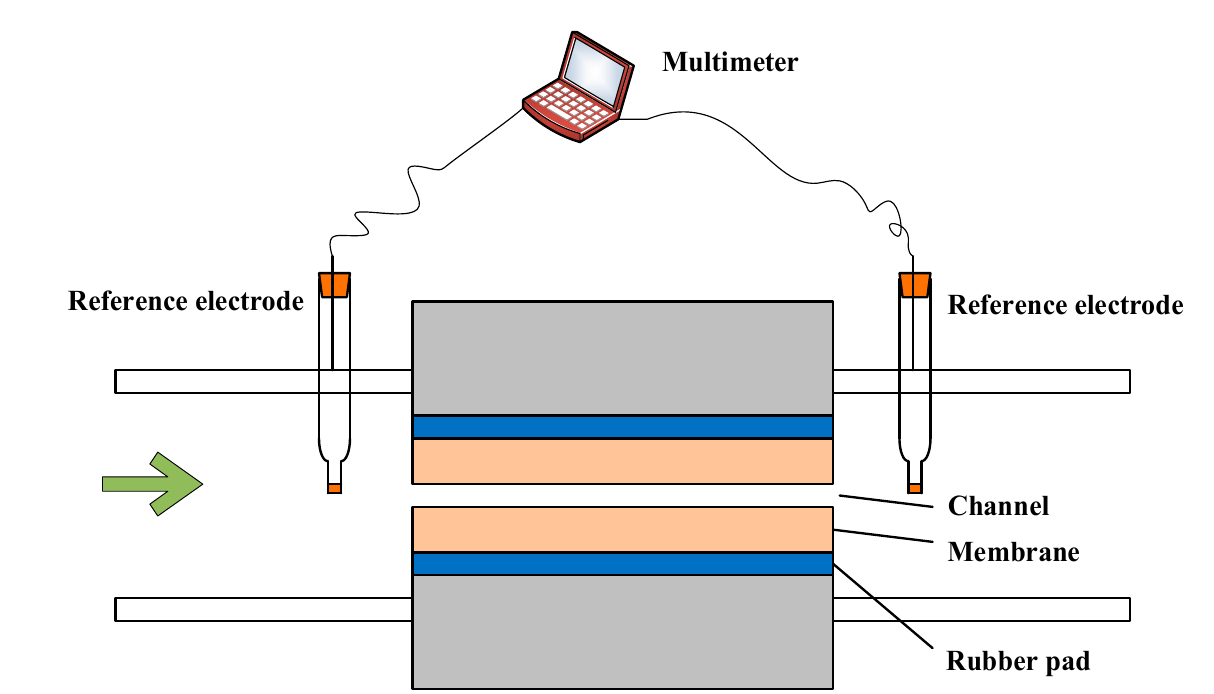
Figure 2. Schematic of the system setup used for tangential streaming potential measurement.